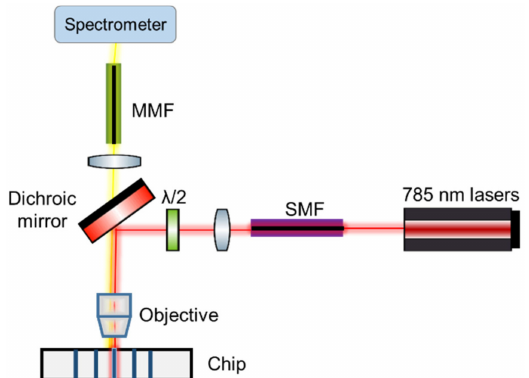
Figure 3. Schematic of an optical setup used to measure the surface-enhanced Raman spectra. Gold nanodomes were measured in a conventional free-space configuration, whereas in the case of the nanoplasmonic slot waveguides, the microscope objective was used to couple the light to the waveguide and then to collect the SERS signal in the back